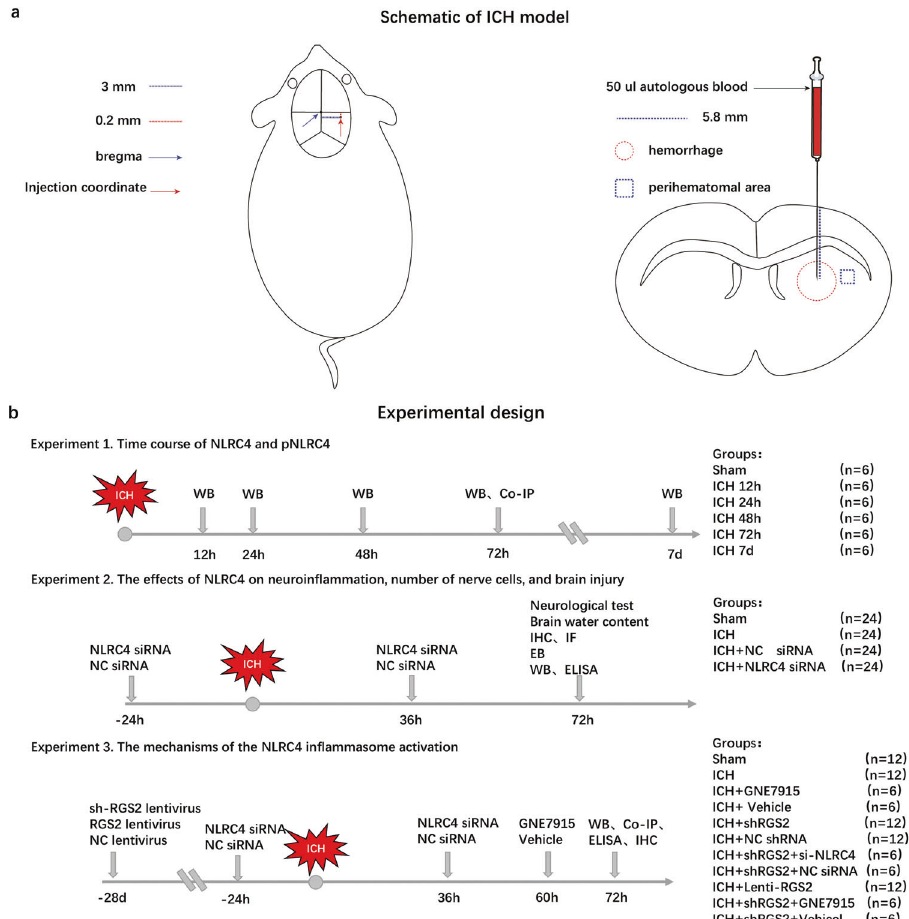
Fig. 1 Schematics of ICH model and experimental design. a A schematic of the ICH model including indication of the stereotactic injection coordinates, hematoma volume, and the regions of the perihematomal area. b A schematic of the experimental design and animal